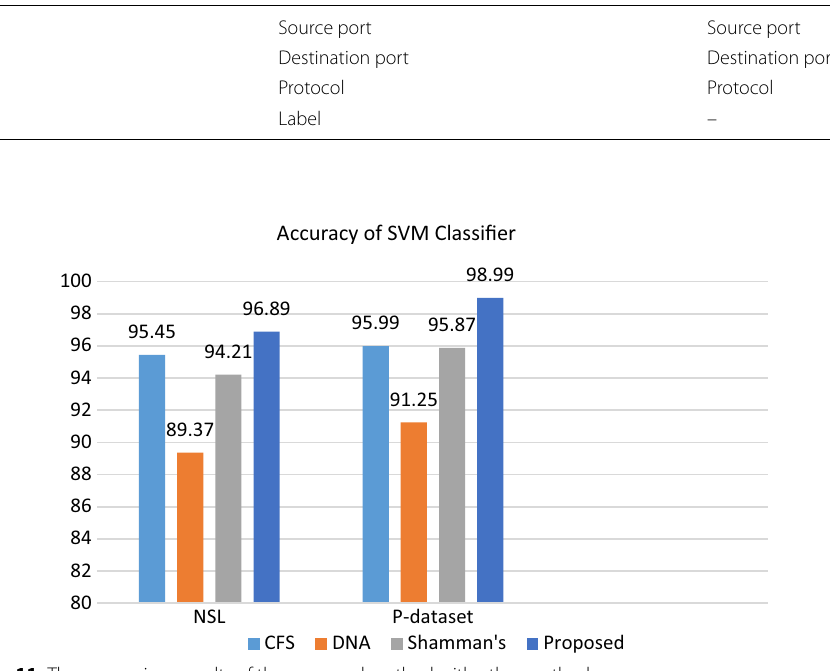
Fig. 11 The comparison results of the proposed method with other